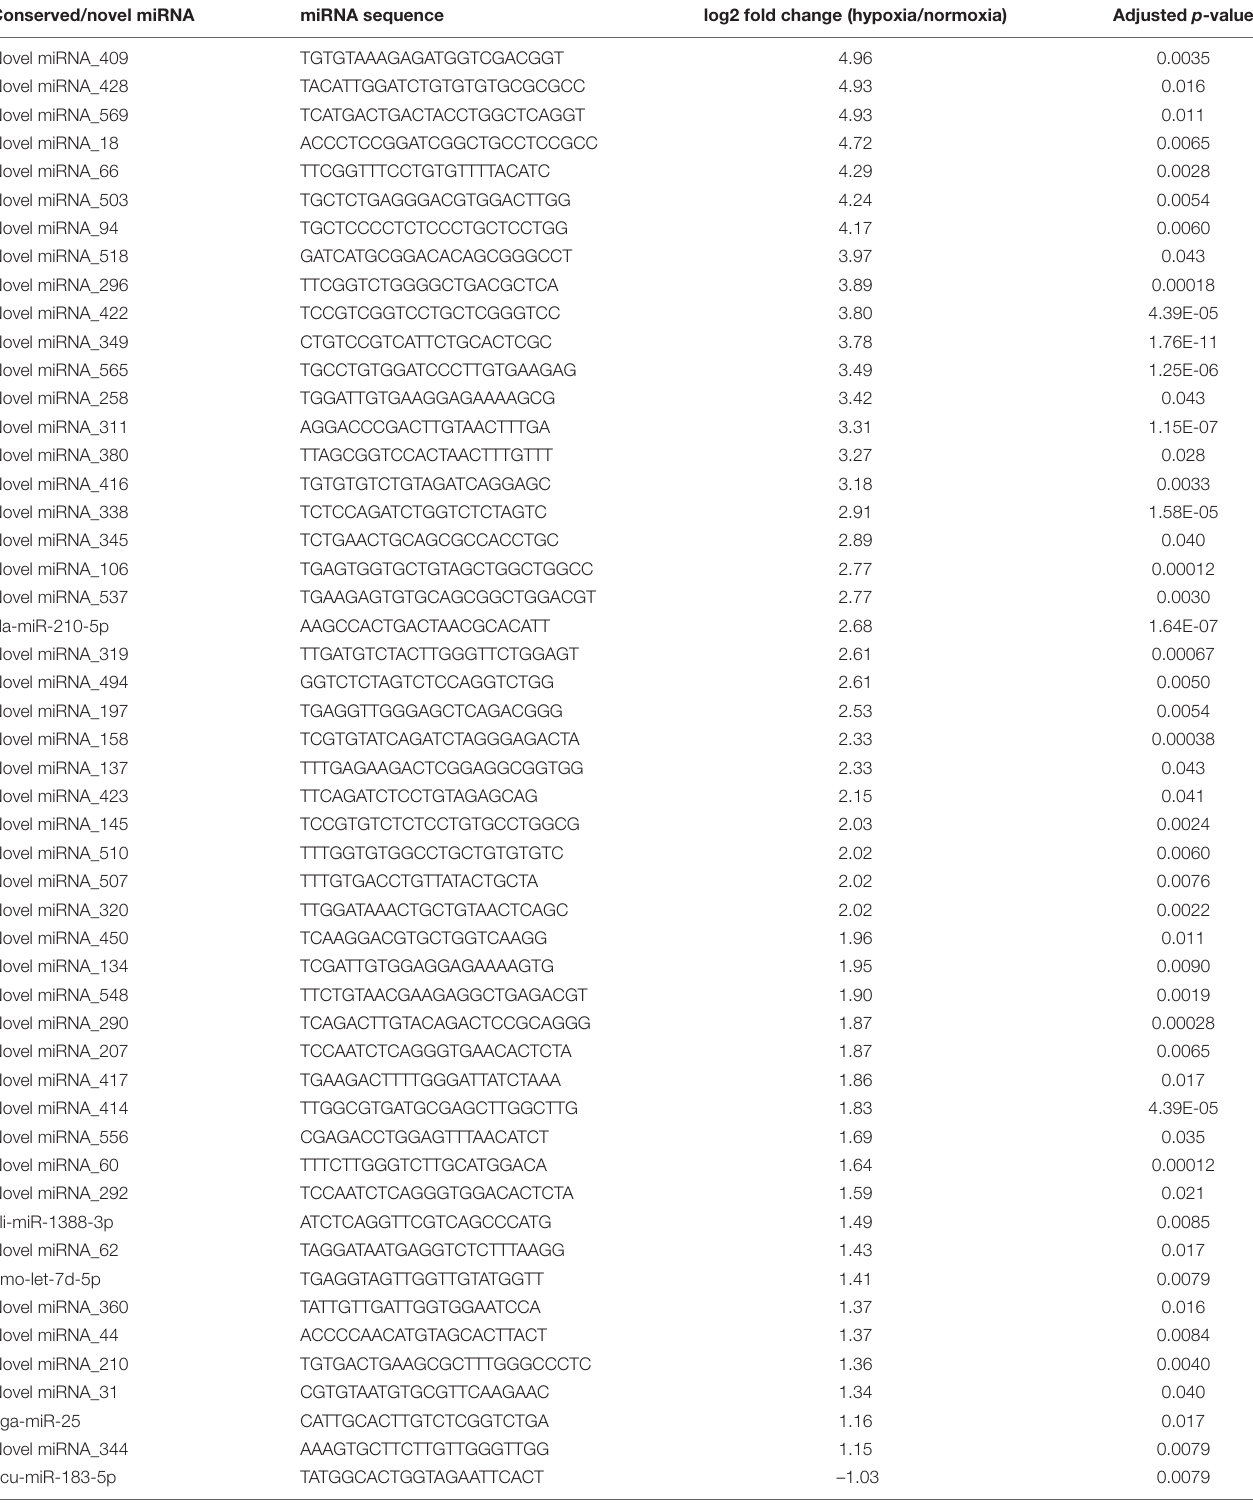
TABLE 2 | Hypoxia dysregulated miRNA in medaka embryos. Conserved/novel miRNA miRNA sequence log2 fold change (hypoxia/normoxia) Adjusted p